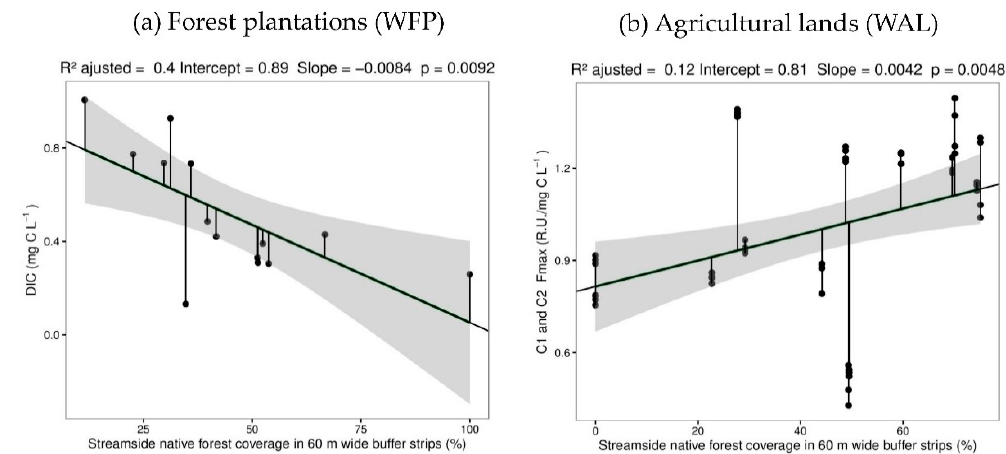
Figure 4. Relating DOM (Dissolved Organic Carbon) quantity and quality with streamside native forests. ( a ) DIC concentration in watersheds dominated by forest plantations (WFP) with 60 m wide streamside native forest ( n = 14); ( b ) The intensity of fluorescence max. of components C1 and C2 in watersheds dominated by agricultural land (WAL) with streamside native forests coverage in buffer strips of 60 m wide ( n = 56). Grey color indicates 98% confidence region.